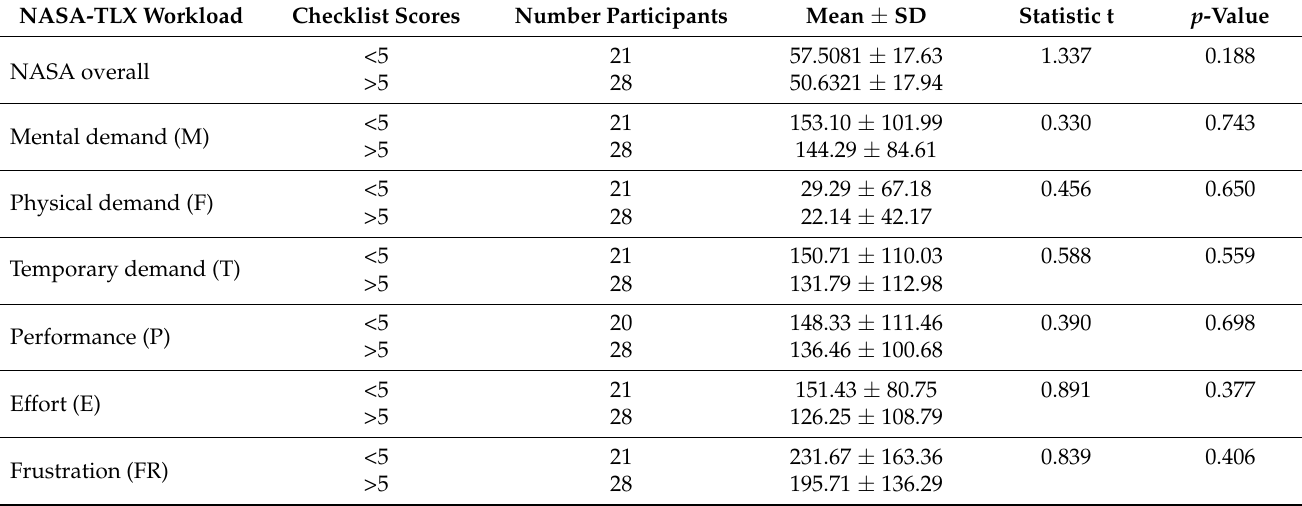
Table 4. Relationship of workload variables with checklist